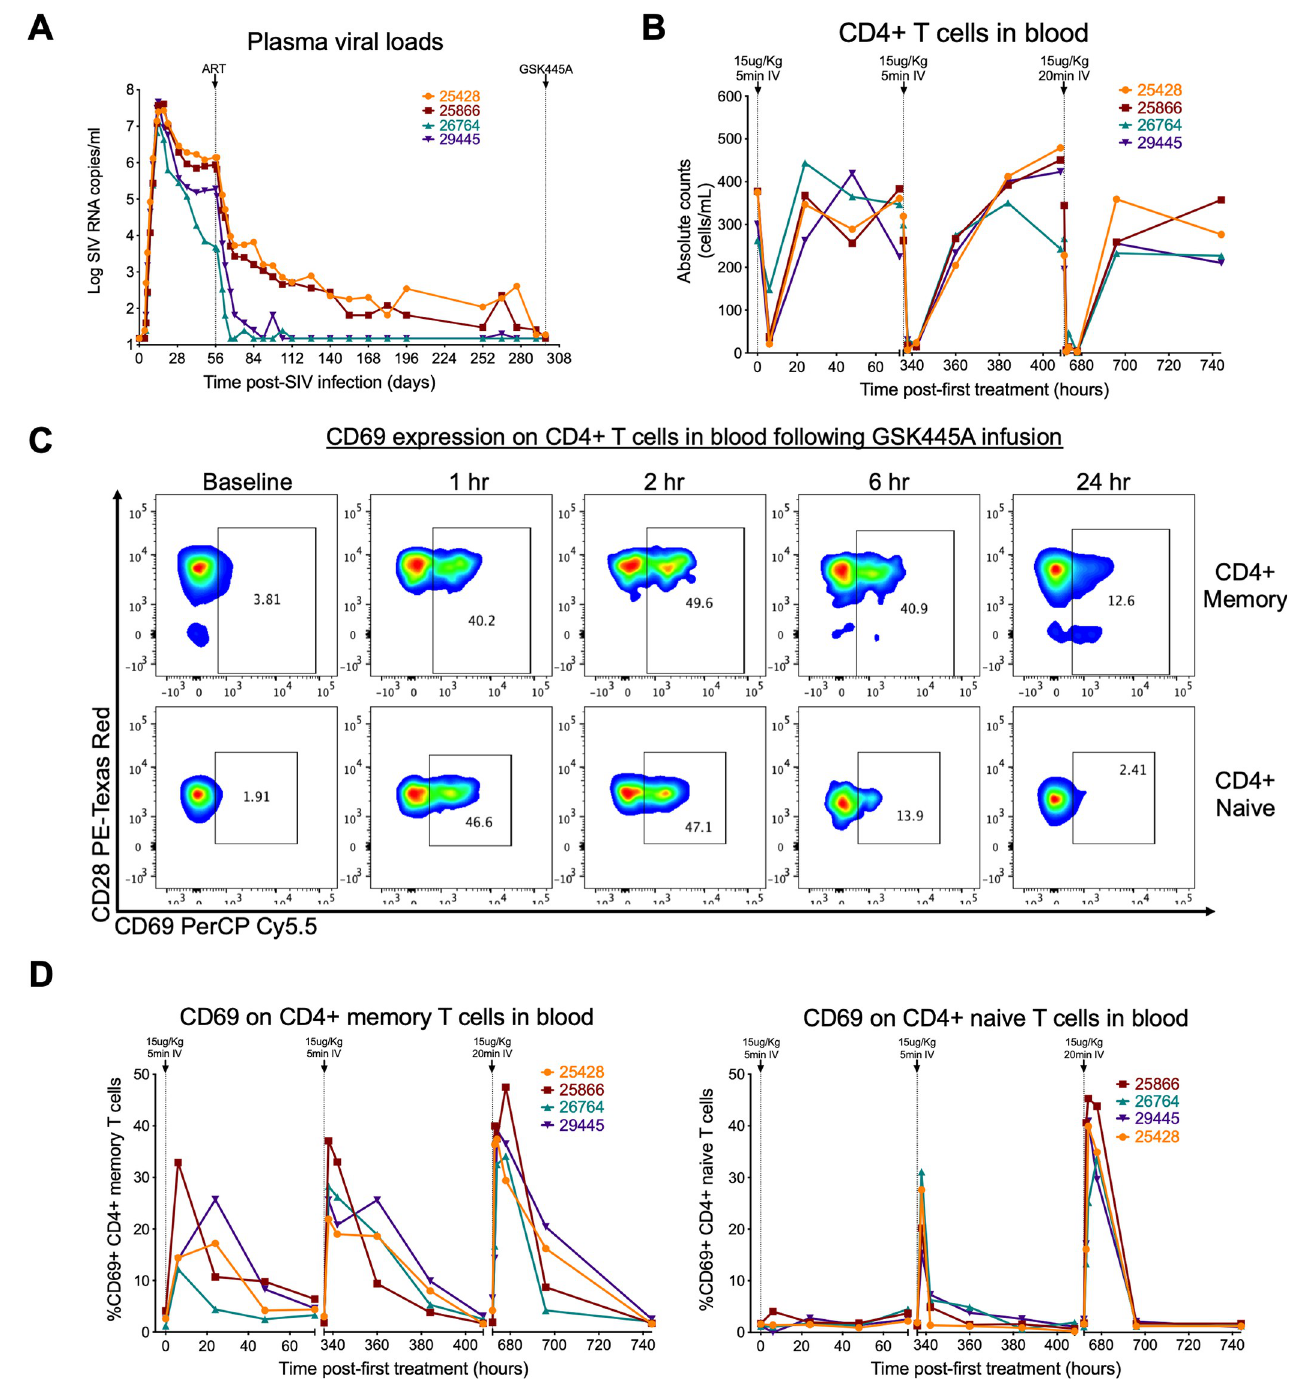
Fig 5. Effects of GSK445A on CD4 + T cell dynamics in SIV-infected RM on ART. (A) Plasma SIV RNA profiles for 4 RM following SIVmac239M infection, ART initiation on day 56 post-infection (pi) and GSK445A infusion starting day 298 pi. (B) Absolute counts of CD4 + T cells in blood following 3 infusions of GSK445A at 15 μ g/kg. Note that the first 2 doses of GSK445A were administered over 5 minutes while the 3rd dose was administered over 20 minutes. (C) Representative flow cytometric analysis of RM RM25866 showing CD69 expression on CD4 + memory and na ï ve T cells in peripheral blood up to 24 hours following the third infusion of GSK445A at 15 μ g/kg. (D) Frequencies of CD69 + CD4 + memory T cells (left panel) and CD69 + CD4 + na ï ve T cells (right panel) in blood following GSK445A infusion.